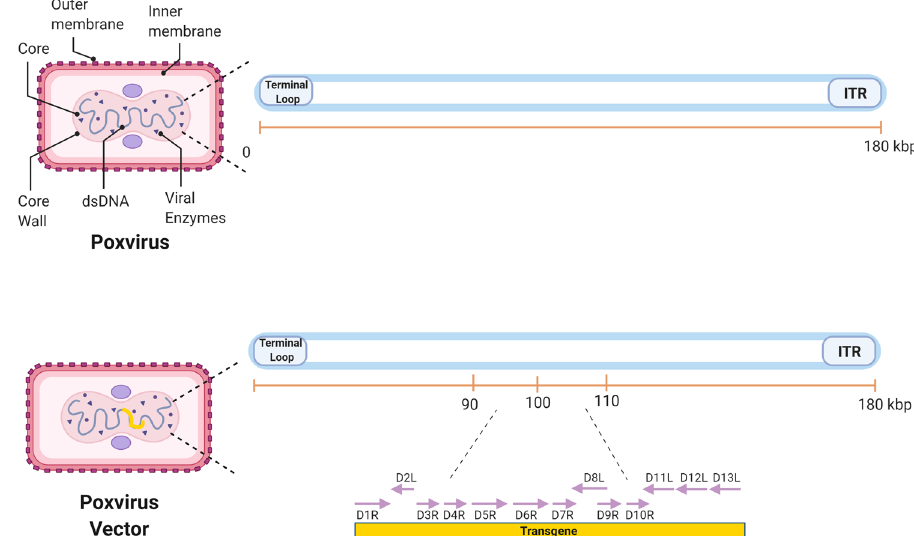
Fig. 5 Schematic representation of a poxvirus genome fl anked by one origin for DNA replication and one terminal loop. The central region of the genome contains a conserved series of genes needed for viral replication. The two fl anking regions code for several proteins that help determine virulence. When used as a viral vector in vaccinations, the D1 – 13 transcription units (indicated between the dotted lines) are replaced by the transgene of